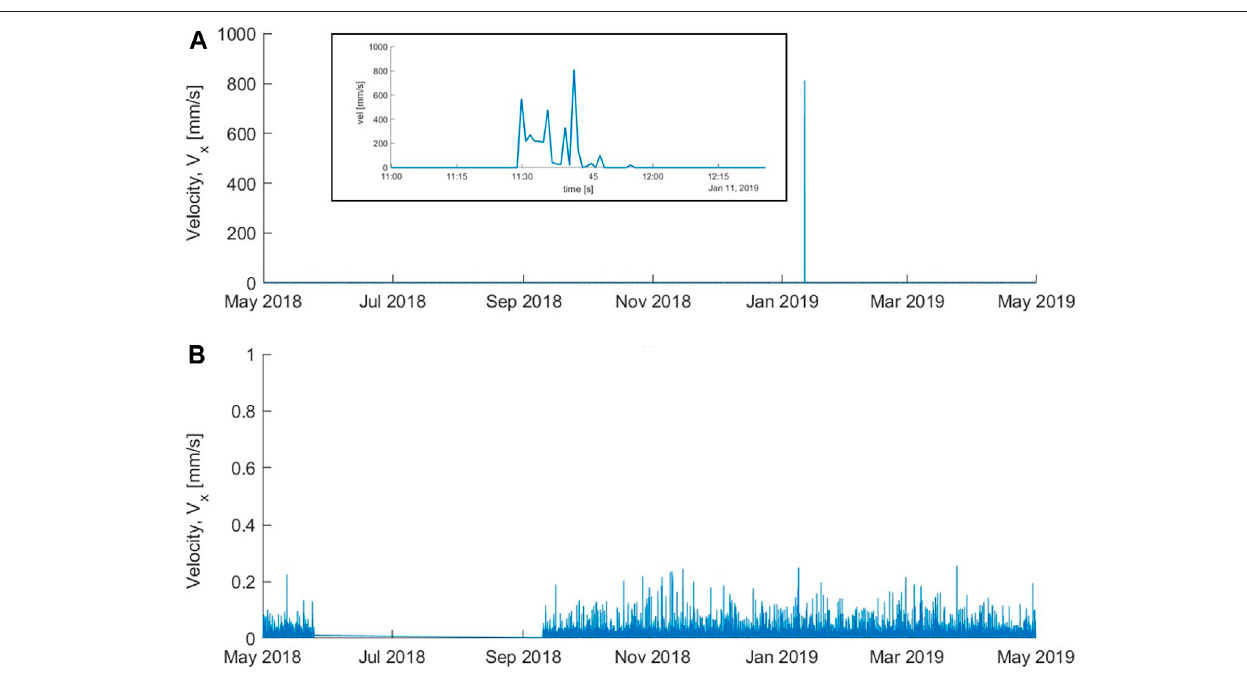
FIGURE 3 | Heartbeat peak velocity traces (X-direction) obtained from two sensors in the network for the period May 2018 to May 2019: (A) sensor with a large peak in the dataset, and (B) sensor with a period of missing